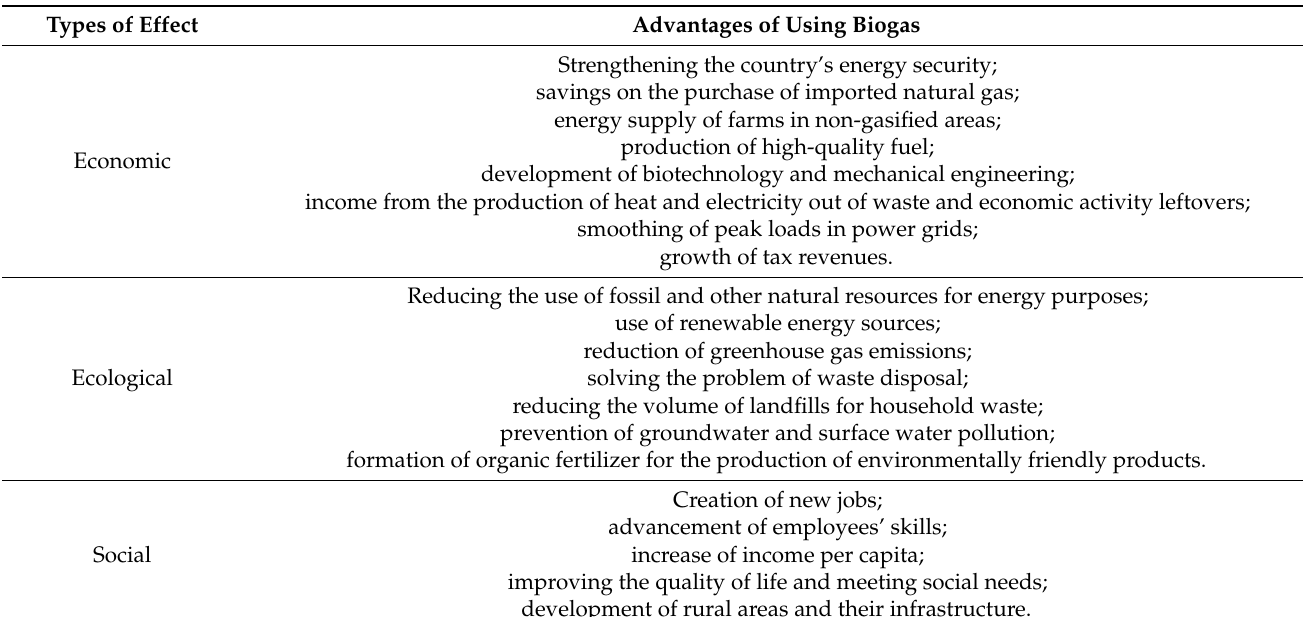
Table 4. Effects from the implementation of biogas